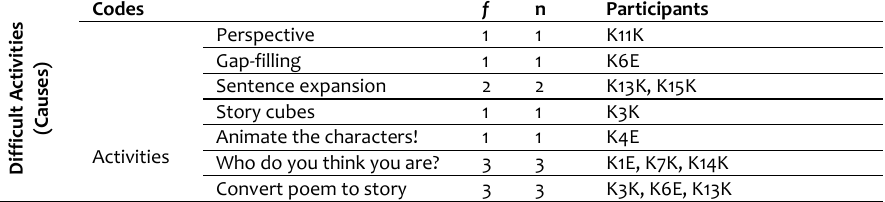
Table 7. Findings Regarding Difficult Activities (Causes)